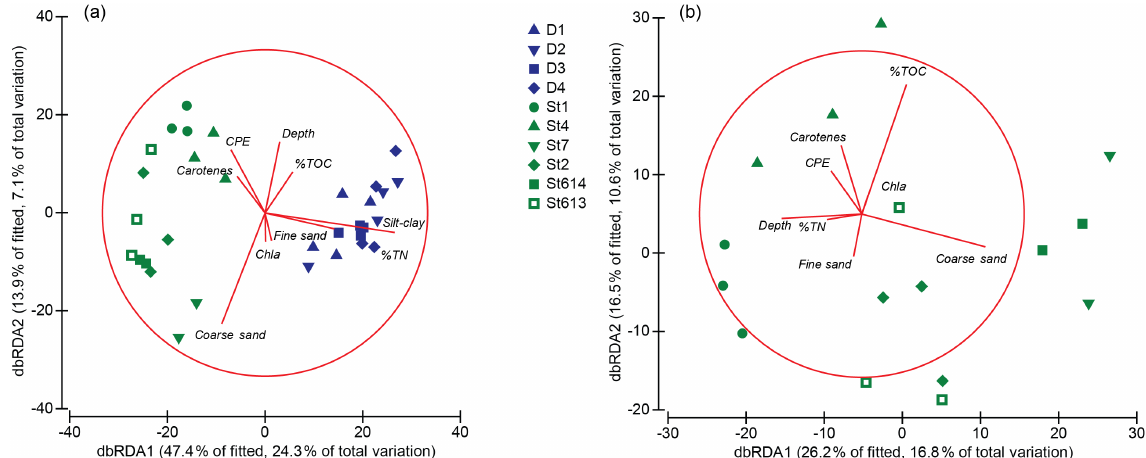
Figure 7. Distance-based redundancy analysis (dbRDA) illustrating the DistLM model based on the genera assemblage data for slope (blue) and shelf-break (green) stations (a) and only between shelf-break stations (b) . Fitted environmental variables are shown with their vectors (strength and direction of effect of the variable on the ordination